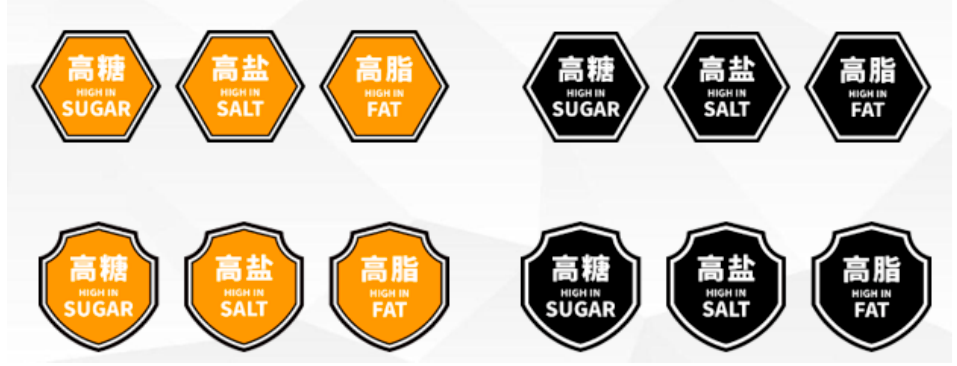
Figure 1. Image of four warning labels designed for Chinese